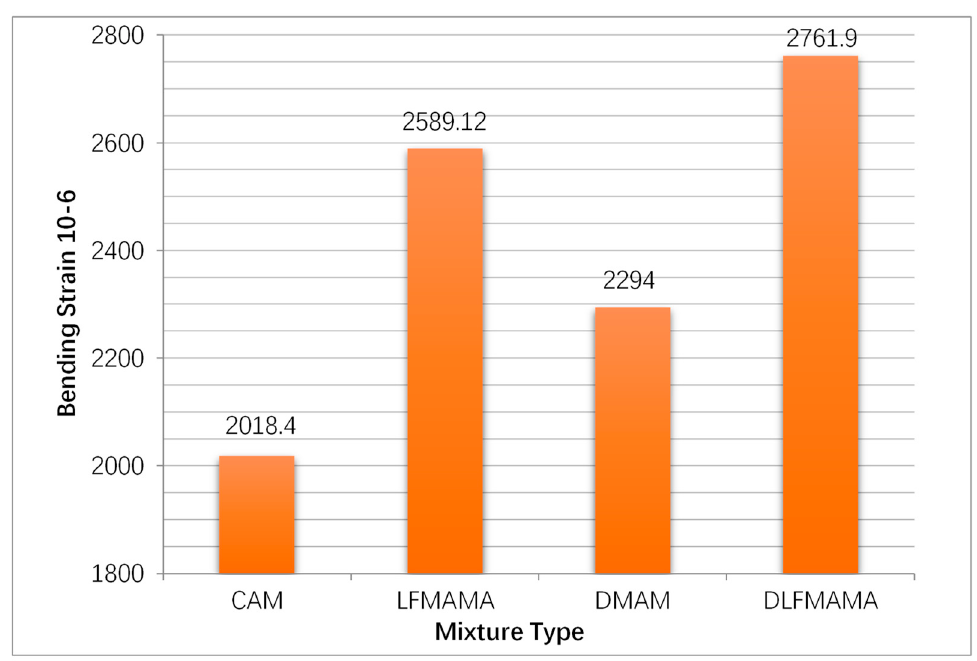
Figure 6. Ultimate bending strain of asphalt mixes.